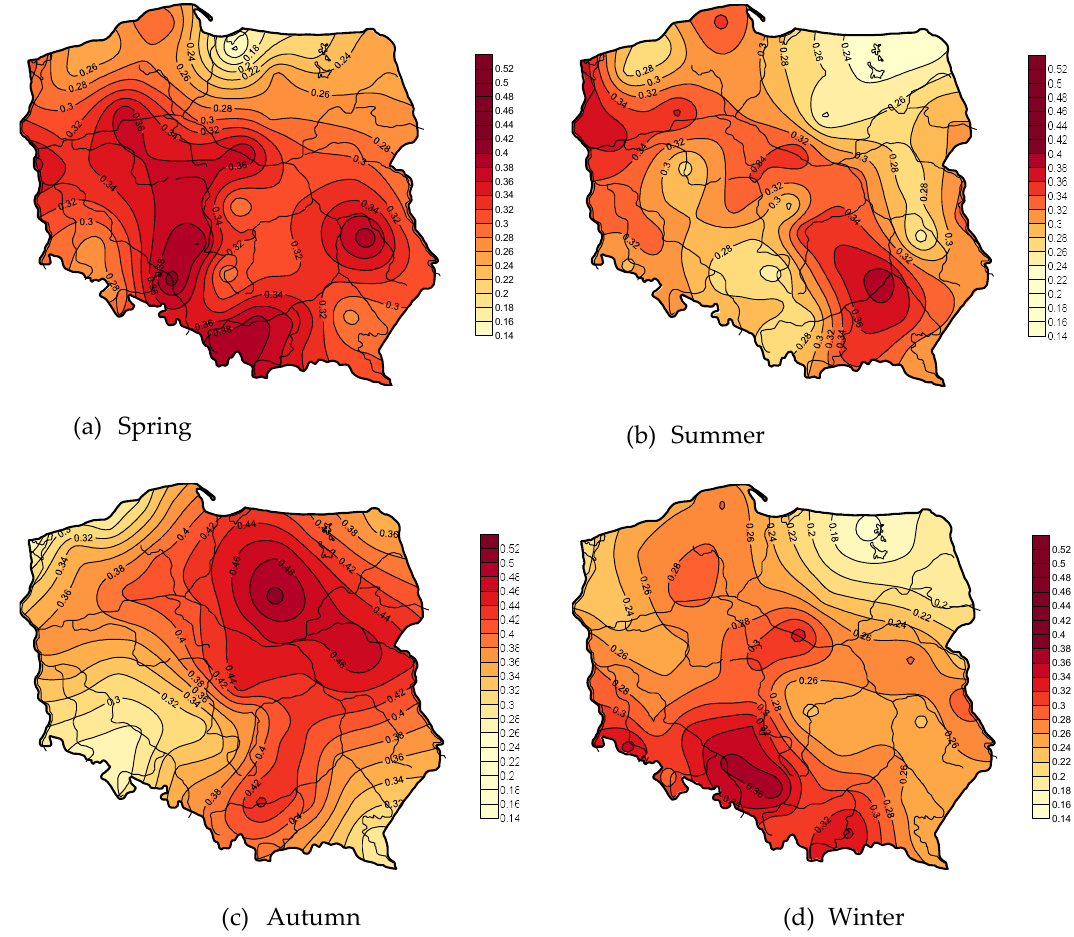
Figure 9. Isarithms of the coe ffi cient of variation of precipitation totals in each season of the years 2001–2018 in Poland: ( a ) Spring; ( b ) Summer; ( c ) Autumn; ( d ) Winter.